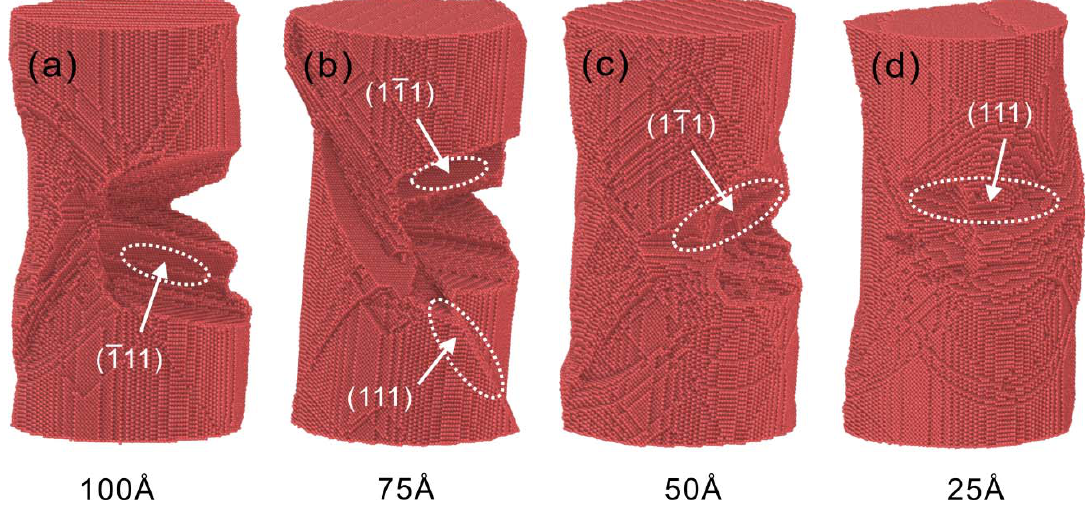
Figure 5. Atomic con fi gurations for four depths of cracks at strain ε = 50% for a strain rate of 1 × 10 8 s − 1 . ( a ) 100 Å, ( b ) 75 Å, ( c ) 50 Å, ( d ) 25 Å. The arrow in the figure shows the plane where the nanowire undergoes shear deformation.